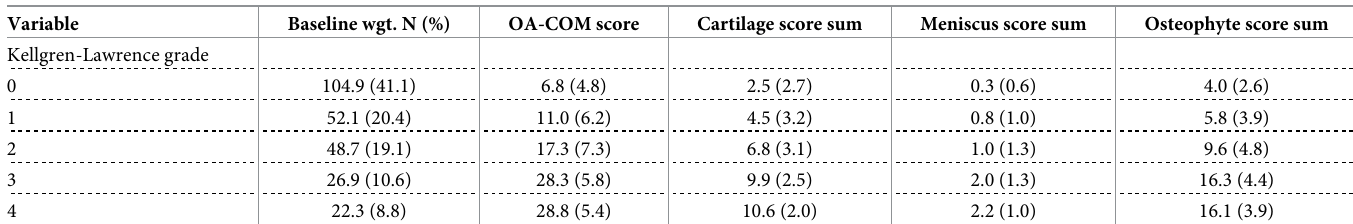
Table 1. Sample characteristics in the baseline sample (N = 255): Mean (SD). Variable Baseline wgt. N (%)